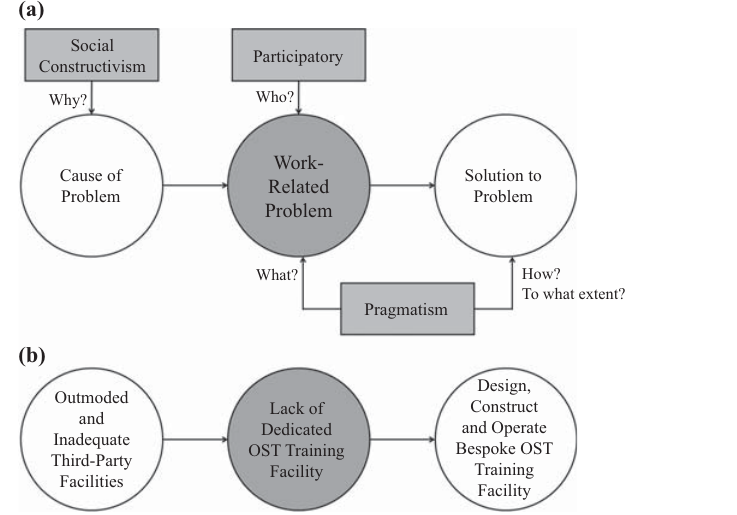
Figure 1. Research paradigms and their relation to a work-related problem (a) and example of the standard